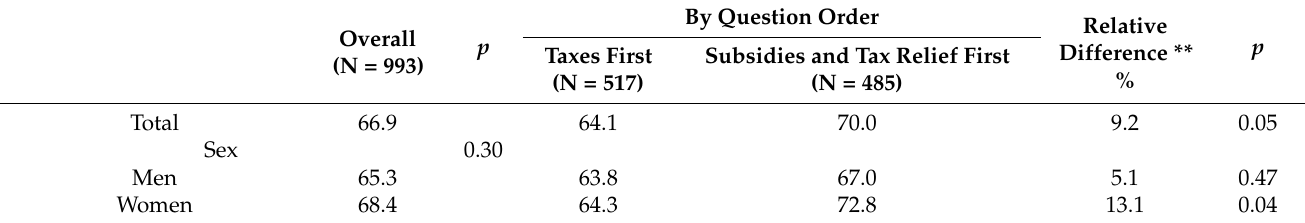
Table 3. Prevalence of support for a tax on sugar-sweetened beverages, overall and by order of questions on price